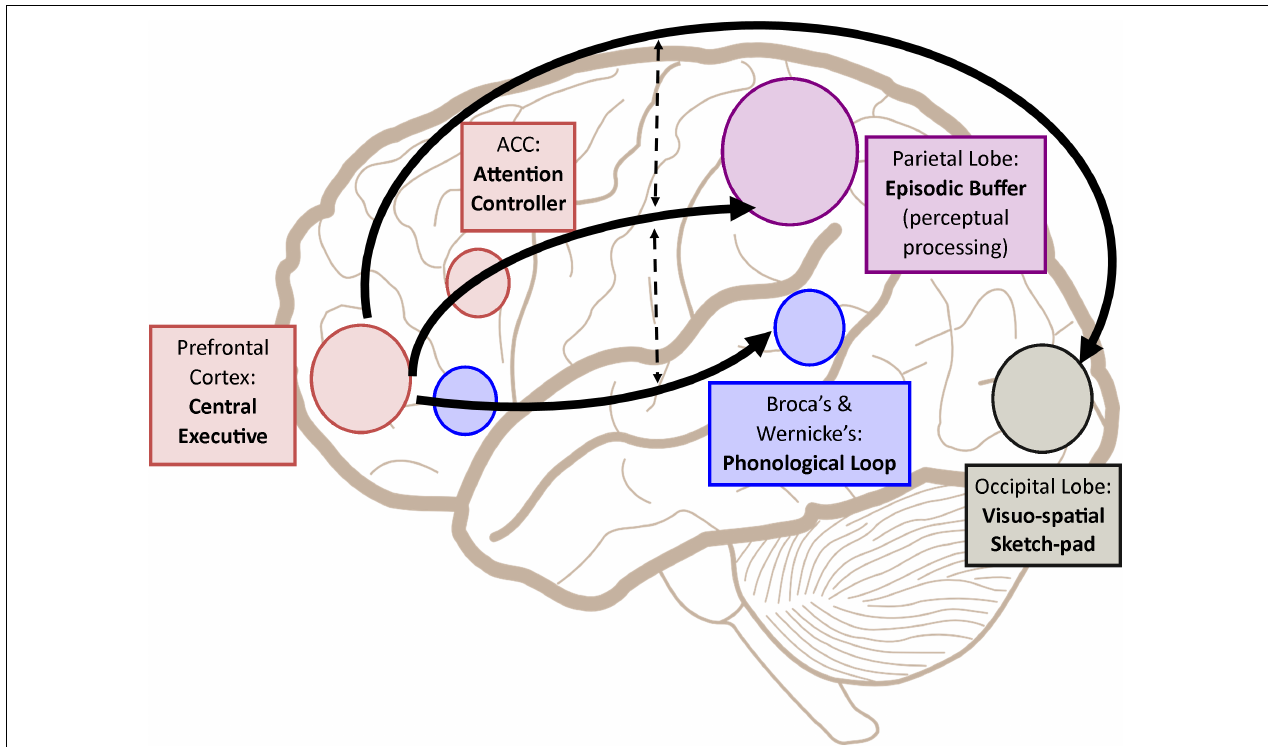
FIGURE 1 | A simplified depiction (adapted from the multicomponent working memory model by Baddeley, 2010) as implicated in the brain, in which the central executive assumes the role to exert control and oversee the manipulation of incoming information for intended execution. ACC, Anterior cingulate cortex.